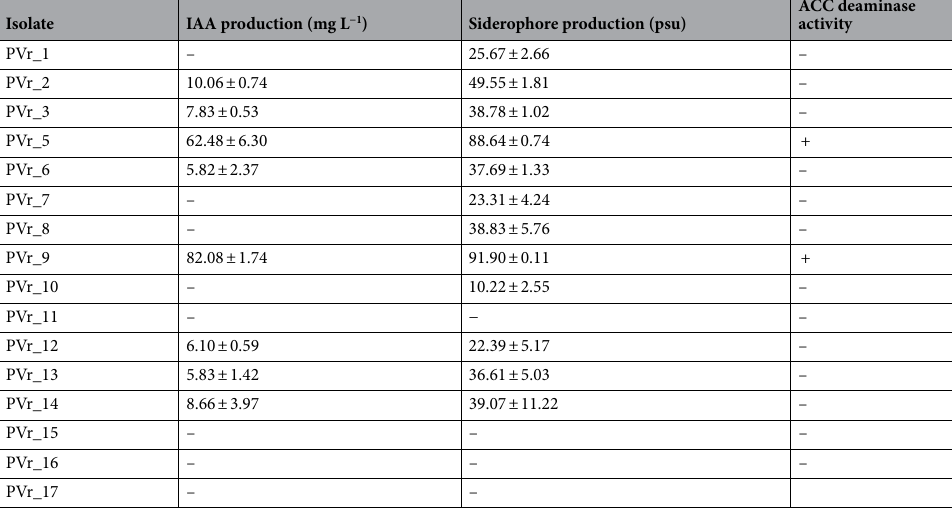
Table 3. Plant growth promoting activities of bacterial isolated from Pteris vittata roots. Data are averages of three independent experiments ± S.D. IAA production: (-) < 5 mg L −1 . Siderophore production: (−) < 10 psu. ACC deaminase activity: (−) no bacterial growth on medium containing 1-aminocyclopropane-1-carboxylate as the only N source; (+) bacterial growth on medium containing 1-aminocyclopropane-1-carboxylate as the only N